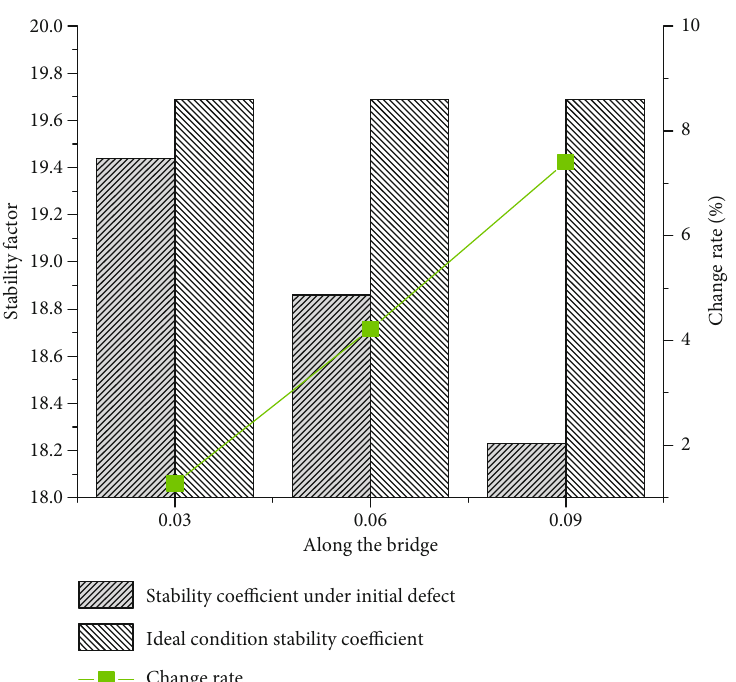
Figure 11: Stability coe ffi cients of the bridge under di ff erent working